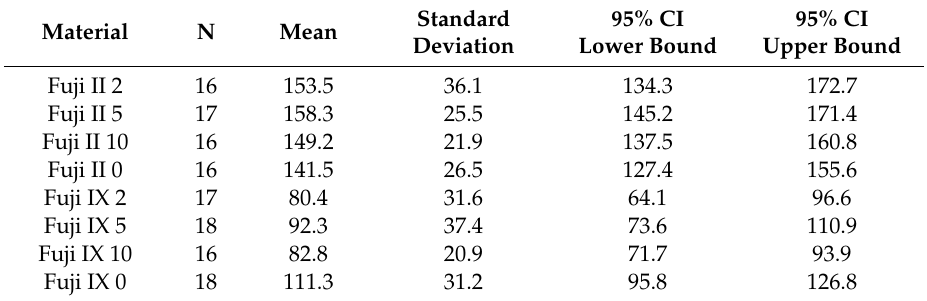
Table 1. Descriptive statistics for compressive strength in MPa (sample size, mean value, standard deviation, lower and upper bounds for 95% confidence interval.